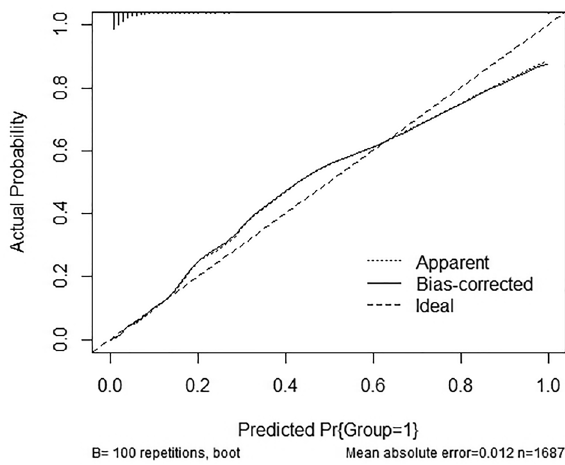
Figure 3. The calibration curves of the